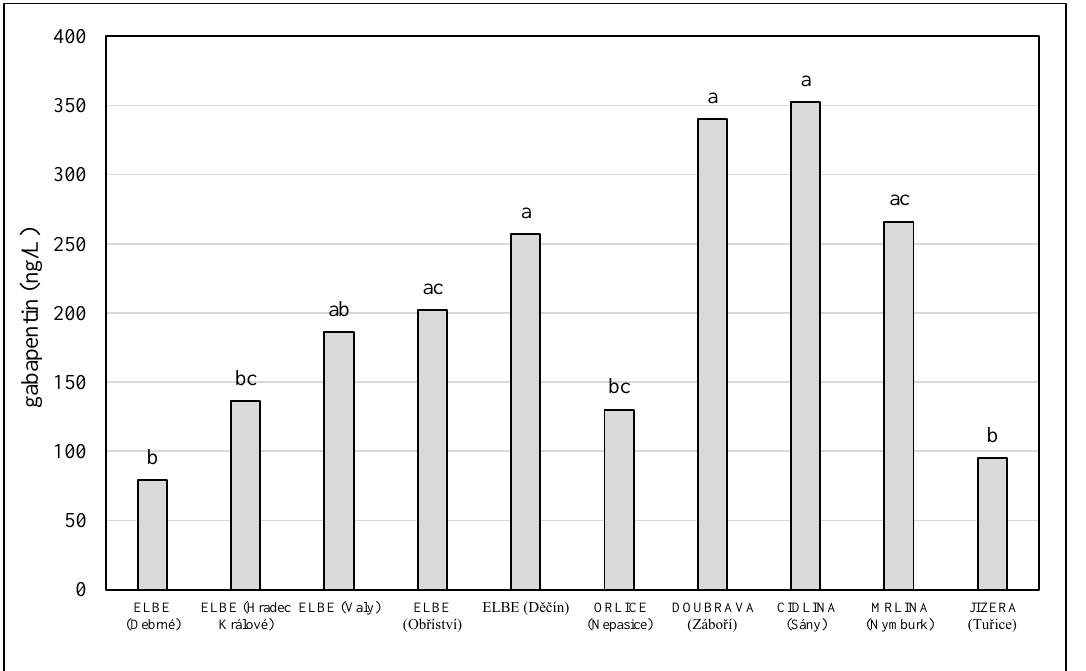
9 of 17 Table 2. Results of the Spearman ’ s rank-order correlation for concentrations of individual anticonvulsive drugs and flow rate at monitored localities during the year 2021. The statistically significant Spearman´s rank coefficient ( p < 0.05) is indicated in boldface. Localities